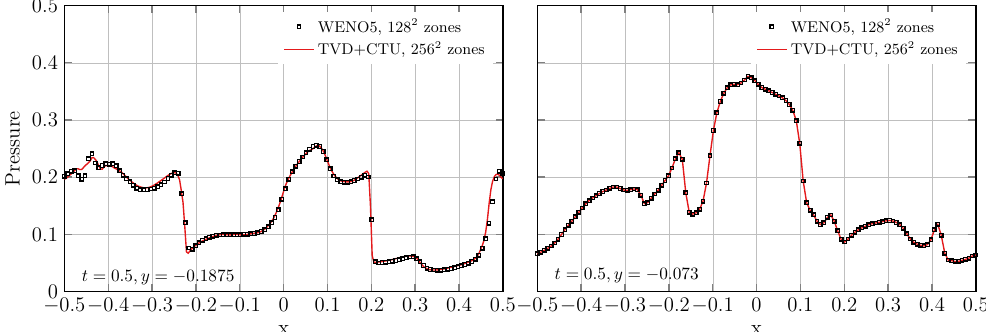
Figure 3. Pressure slices in the 2D Orszag-Tang Vortex test at y = TVD solution with 256 2 zones (red line), WENO5 solution with 128 2 zones (black